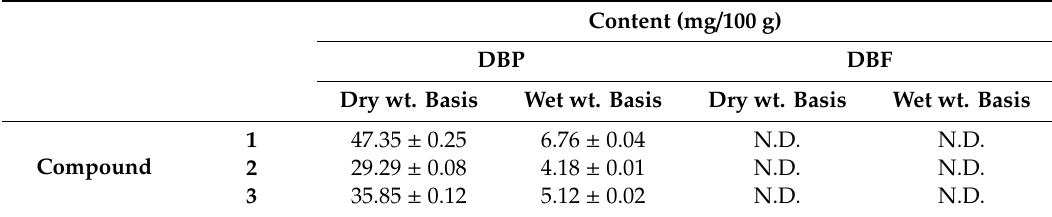
Table 2. Contents of Phenanthrenes 1 – 3 in the DBF and DBP 95% ethanol